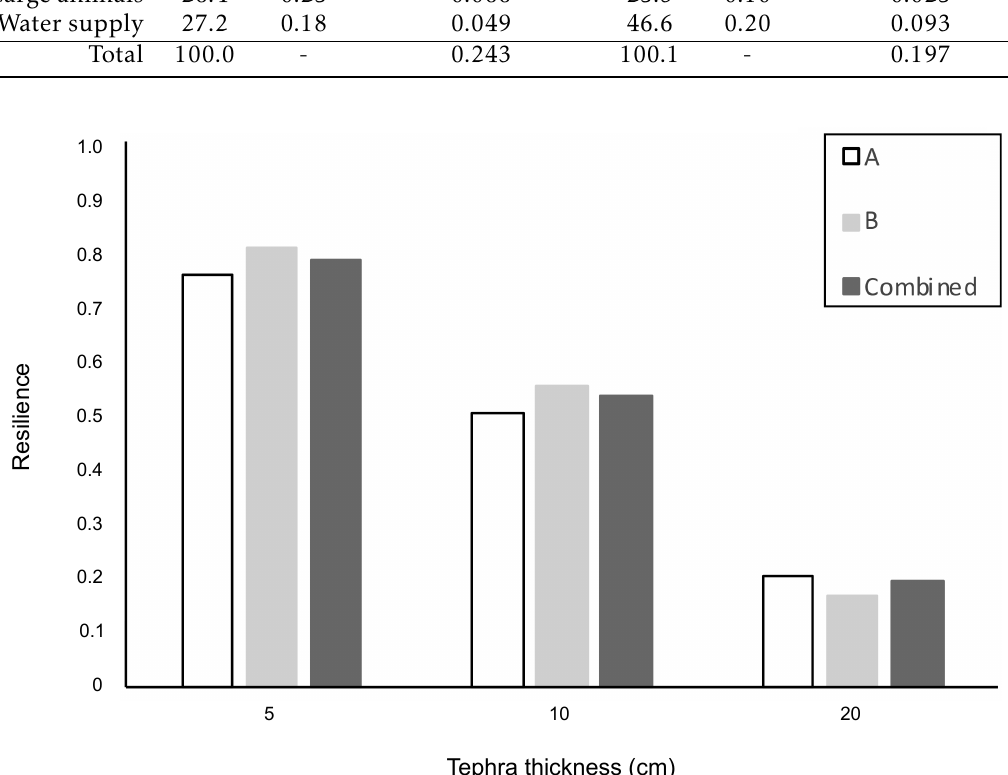
Figure 4: Resilience ( R = 1 − V ulnerability ) of Palaeolithic foragers in Europe to Laacher See tephra fall thick- nesses of 5, 10, and 20 cm, estimated by independent expert